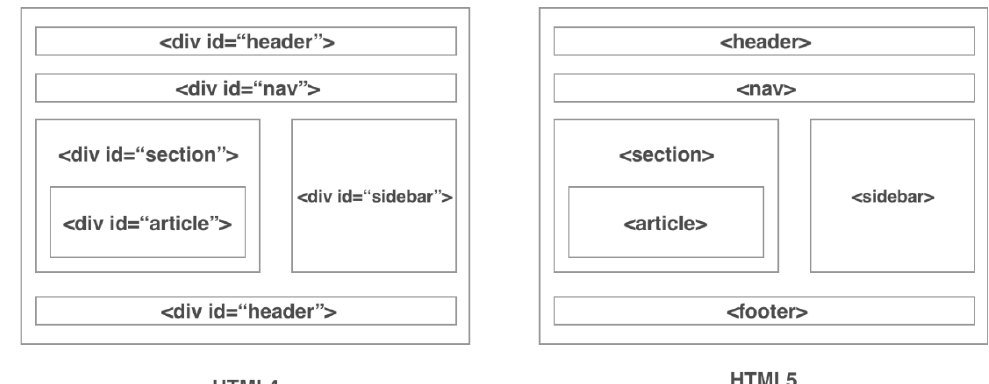
Figure 2. Example of a basic HTML structure of a simple layout in two versions. At left, the version using non semantic tags. At right, the version using semantic